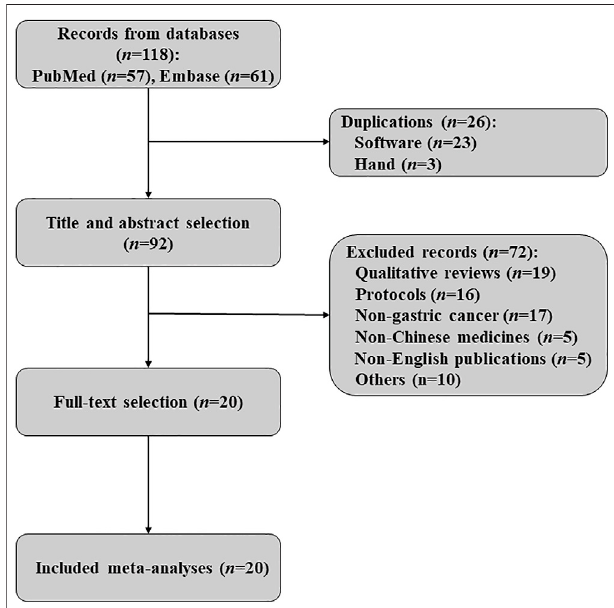
FIGURE 1 | Flow chart of MAs selection for the methodological each MA. Spider charts and forest plots were also used to display the results. Data analysis was performed using Stata 17/SE (StataCorp, College Station, TX, United States) and Excel 2016 (Microsoft Corporation, WA, United States). A two-sided p < 0.05 was considered statistically signi fi cant.